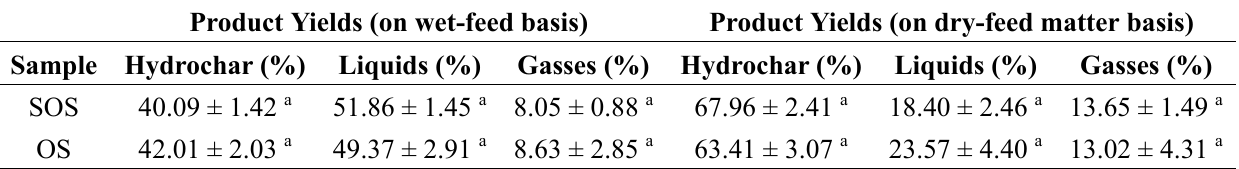
Table 4. Average yield (mean ± SD, replications = 3) of moisture-free hydrochar, liquid, and gas products, on wet-feed basis and on dry-feed basis, from hydrothermal treatment (250 °C for 30 min) of OS and SOS samples generated from blueberry dehydration. Product Yields (on wet-feed basis) Product Yields (on dry-feed matter